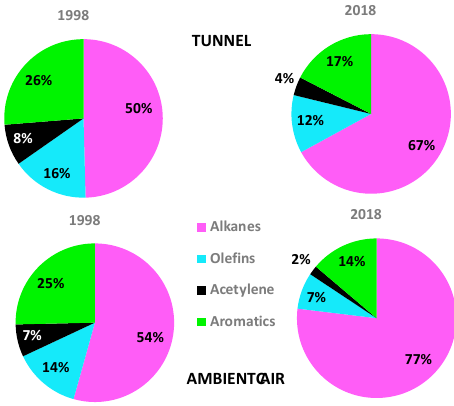
Figure 3. Comparison of the organic group compositions (wt%) in the Chapultepec tunnel and ambient air in 1998 [37] and 2018.